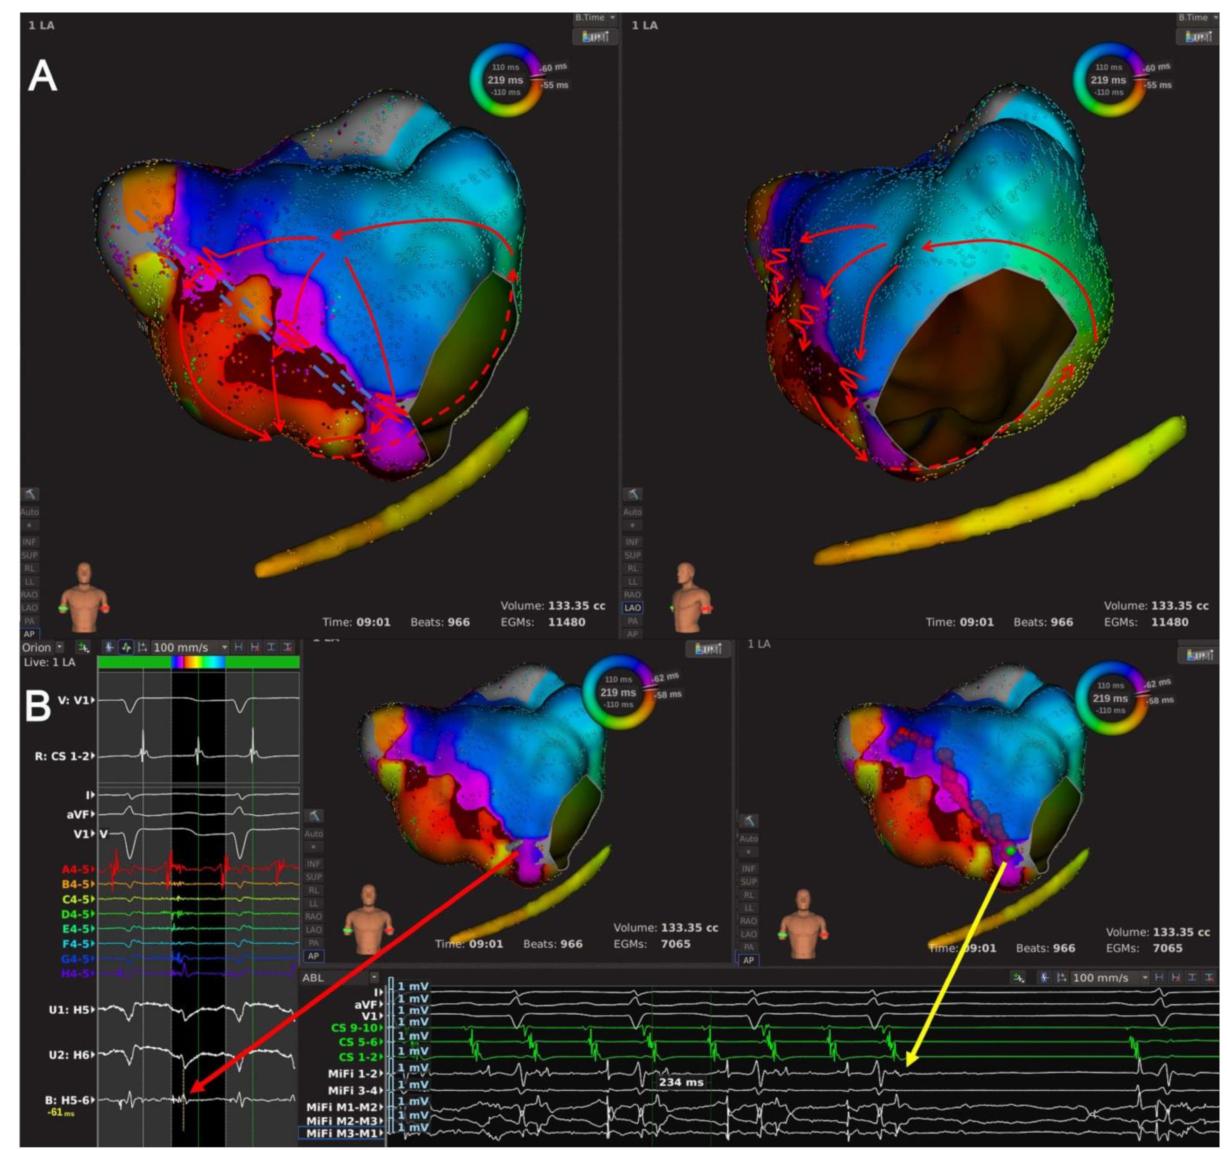
Figure 3. The high-density mapping of a Type 1.2 AT. ( A ) Activation map of a Type 1.2 AT from the anteroposterior view (left) and the left-anterior oblique view (right). The LA high-density mapping identified one LAAW block line from the RSPV to the MVA, with three conduction gaps at the MVA end, near the RSPV end, and in the middle of the LAAW line. The wavefront of AT ran down the LA septum, go along the MVA counterclockwise, and reached the LAAW after passing the MI, then the wavefront jumped across the LAAW conduction gaps almost simultaneously and returned to the LA septum. The red lines with arrows indicated the circuit of AT; the dashed red line indicated the circuit of AT behind the atrial structure; the jagged red lines indicated the wavefront passing the slow conduction areas; the double-dashed blue line indicated the LAAW block of line. ( B ) Local map potentials of the LAAW gap during AT (left) and at the moment of AT termination (bottom). The red dots indicated the ablation points; the green dot indicated the termination site; the arrowed red and yellow lines indicated the local potentials during AT and at the moment of AT termination,